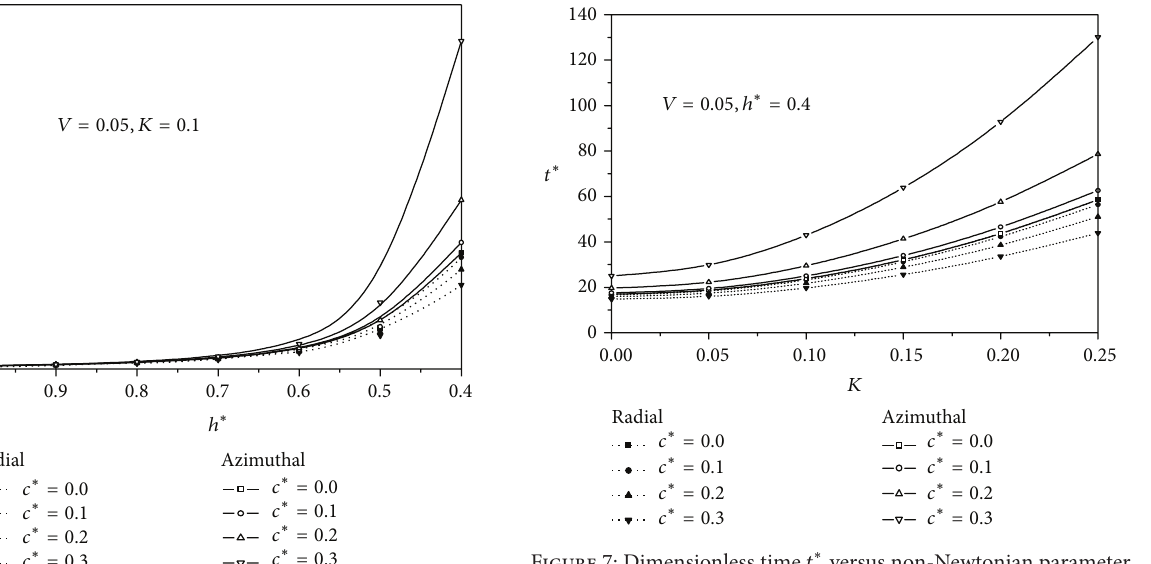
Figure 5: Load capacity 𝑤 ∗ versus the film thickness ℎ ∗ for different 𝑐 ∗ .